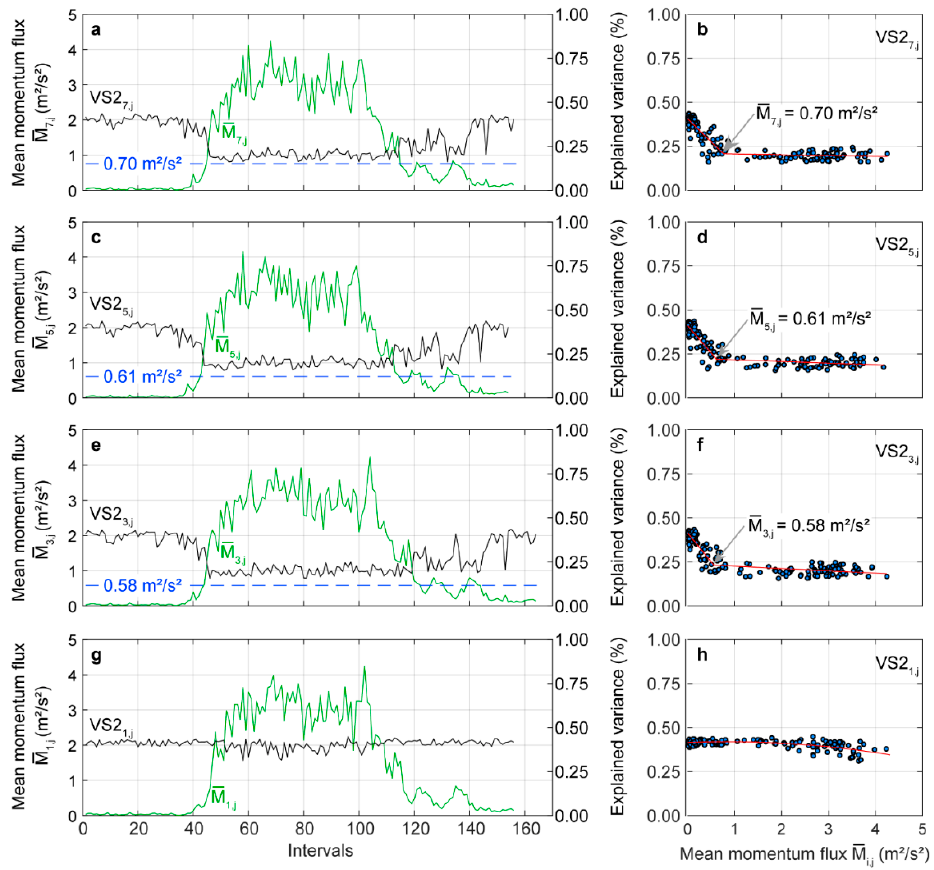
Figure 7. ( a , c , e , g ) Explained variance associated with the oscillatory ( OS i,j ) singular spectrum analysis (SSA) component ( VS 2 i,j with i = 1, 3, 5, 7) in dependence of mean momentum flux at canopy top ( M i,j ) on 30 January 2019. The red lines that are shown in the subplots in the right column of the figure were calculated with ( b , d , f ) two-phase regression models and ( h ) a second-order polynomial regression model.